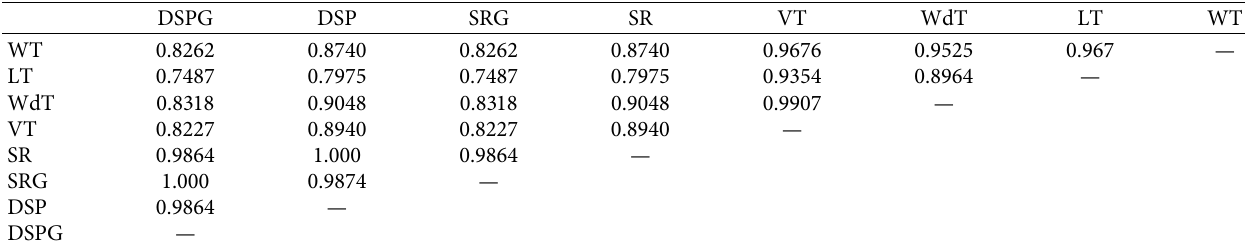
Table 3: Coefficient ( r ) of correlation between testicular morphometric parameters, sperm reserves, and sperm production in Ghanaian WAD rams ( n � 12).